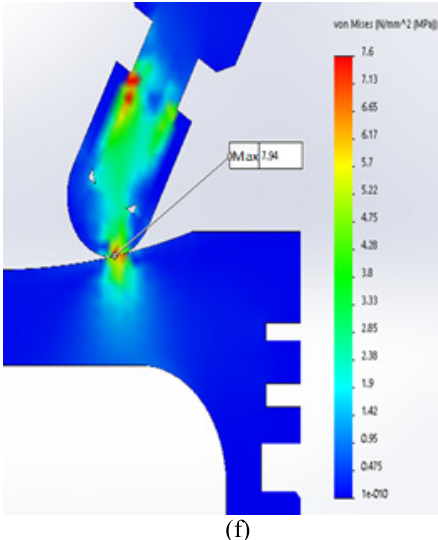
Figure 16. Calculation results in the Solid Works Simulation application: (a) 250 rpm, (b) 300 rpm, (c) 350 rpm, (d) 500 rpm, (e) 600 rpm, (f) 700 rpm.